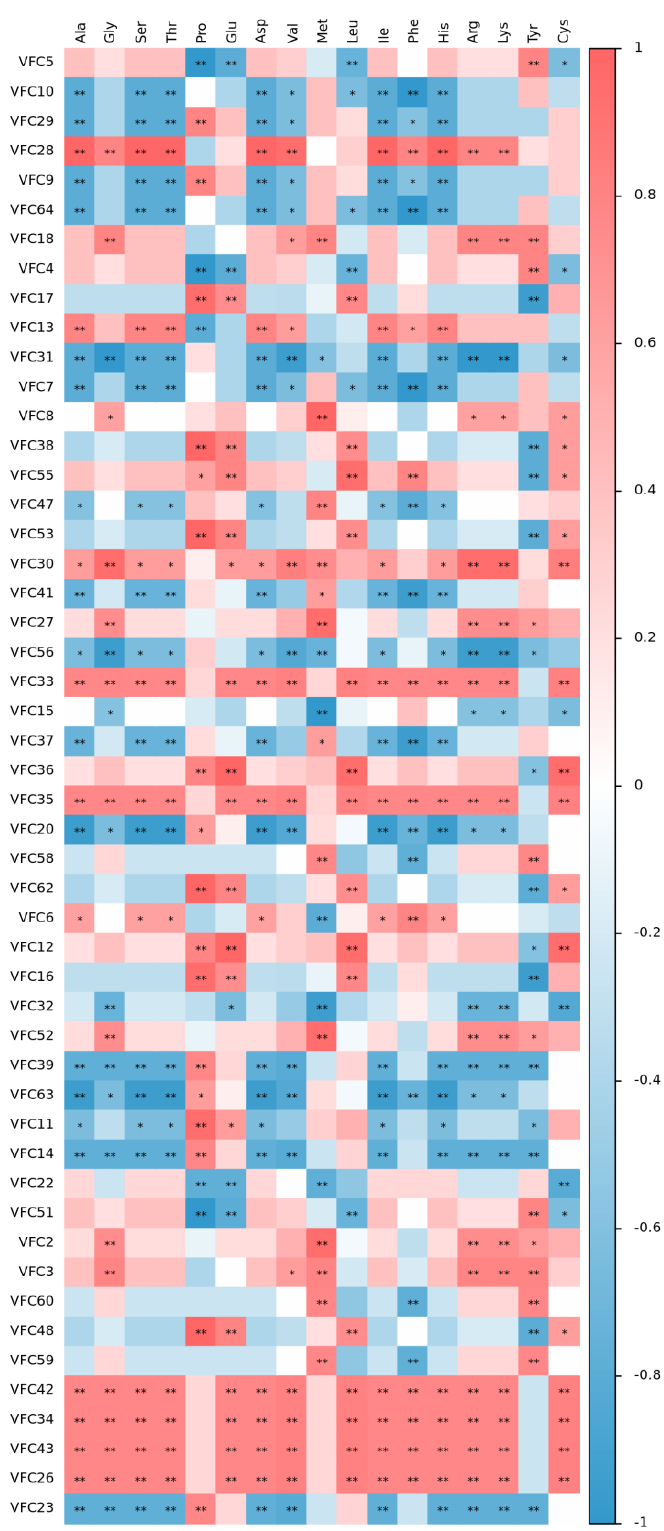
Figure 3. Correlation heat map between amino acids and flavor substances in pretreated oat bran. Red represents positive correlation, blue represents negative correlation, * represents p < 0.05, ** represents p < 0.01.